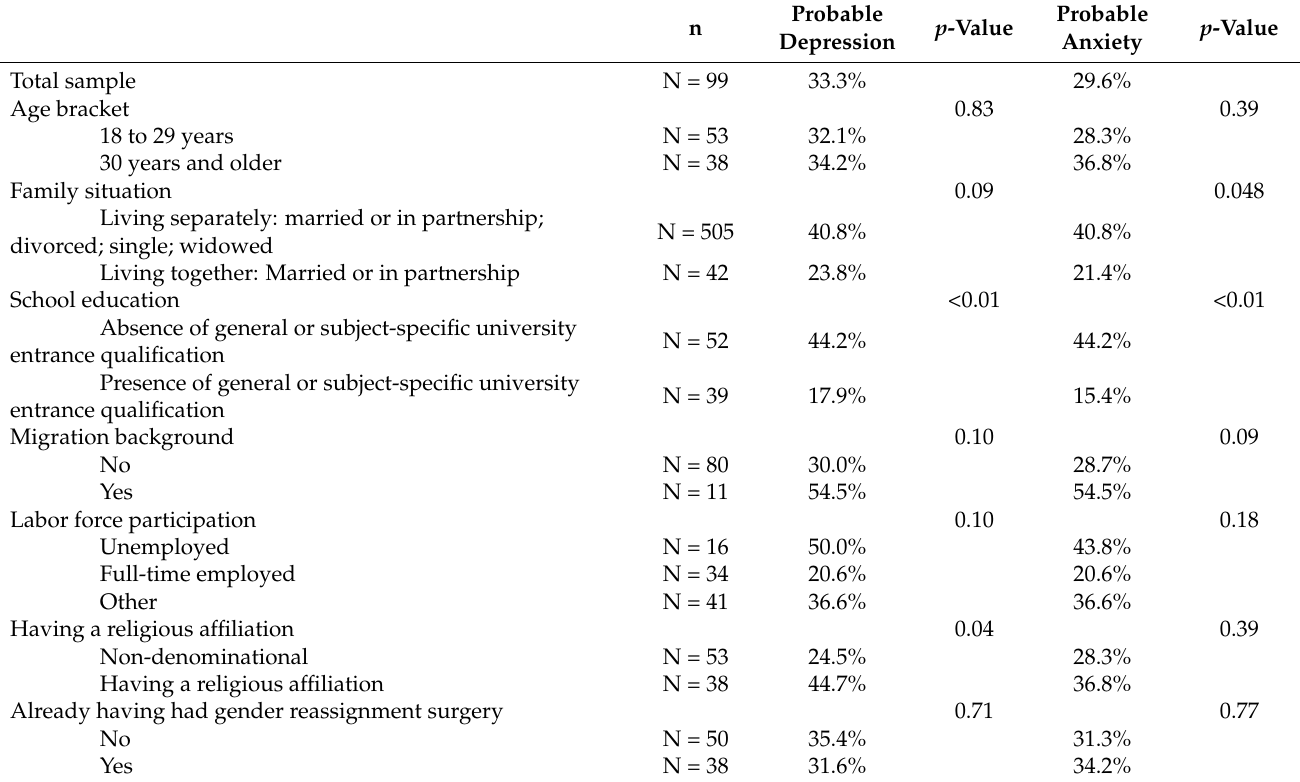
Table 1. Prevalence of probable depression and probable anxiety among several